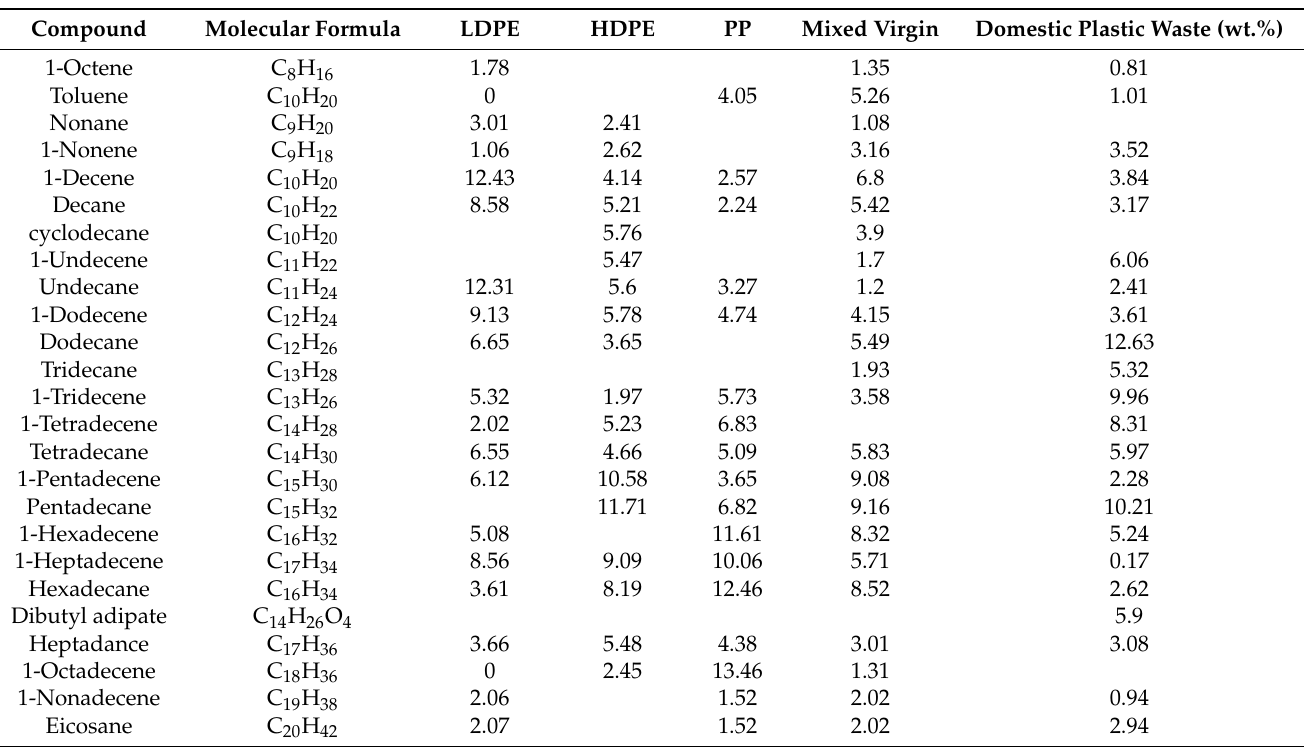
Table 3. Chemical composition of liquid hydrocarbon fuel obtained from LDPE, HDPE, PP, MVP, and